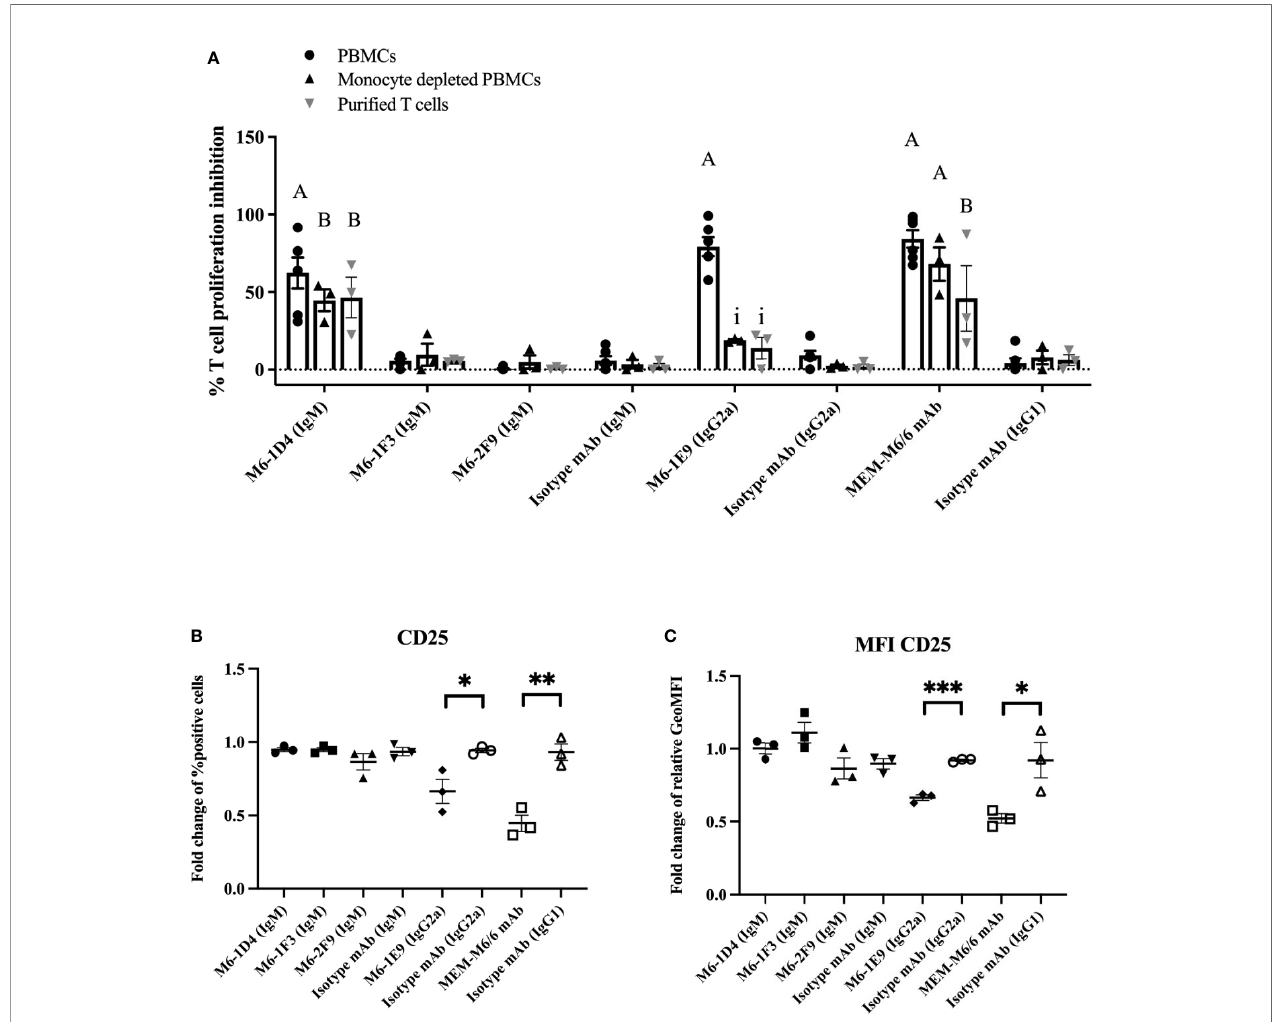
FIGURE 3 | Activation of CD147 on monocytes and T cells with anti-CD147 mAbs regulates T cell activation. PBMCs, monocyte-depleted PBMCs and puri fi ed T cells were activated with anti-CD3 mAb or anti-CD3 and CD28 mAbs in the presence of induced anti-CD147 mAbs or isotype-matched control mAbs. The percent proliferation inhibition in the indicated conditions was calculated by normalizing relative to cells lacking anti-CD147 mAb (A) . PBMCs were cocultured with the indicated anti-CD147 mAb to preactivate THP-1 cells and activated with an anti-CD3 mAb. The fold change of percent CD25-positive cells in T cells (B) and fold change of geometric mean fl uorescence intensity (GeoMFI) (C) are shown in the graph and indicate the mean ± SE. Fold changes are relative to the medium control condition of the three- fi ve individual donors. Statistical analysis was performed using an unpaired t-test. “ A ” represents p ≤ 0.0001 and “ B ” p ≤ 0.01 compared to isotype-matched controls. “ i ” represents p ≤ 0.0001 compared to PBMCs. * represents p ≤ 0.05 and ** p ≤ 0. 01 compared to isotype-matched controls, ***P <